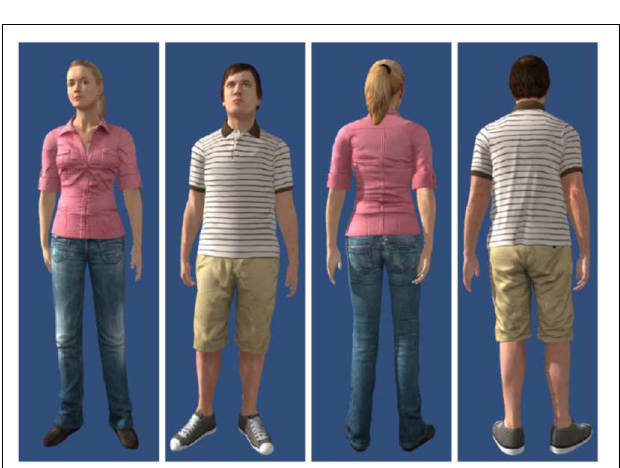
FIGURE 2 | Front and back view of the male and female avatars. The blue background is equal to the free space the avatars were presented in.